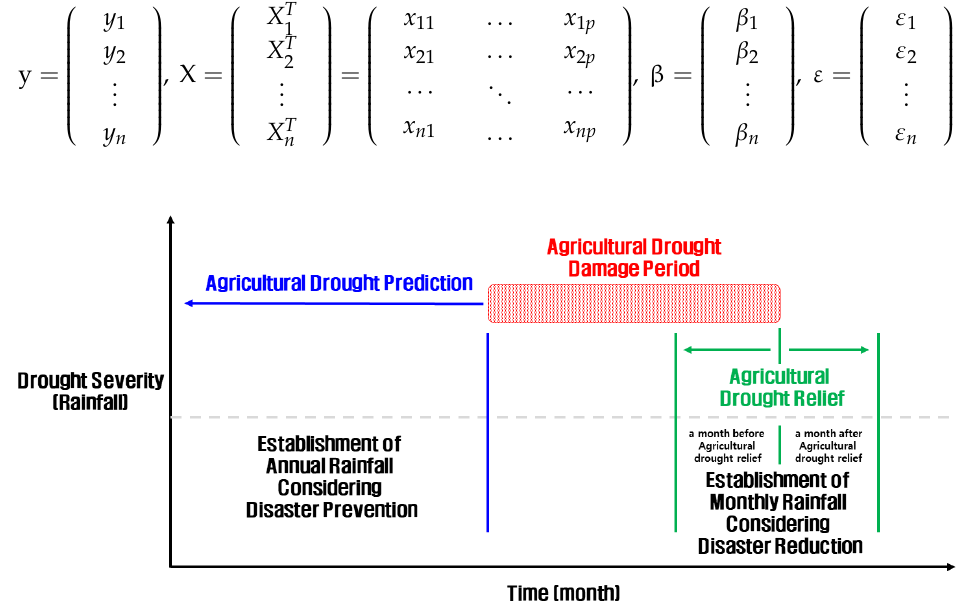
Figure 6. Setting up rainfall for disaster prediction relevant to agricultural droughts.